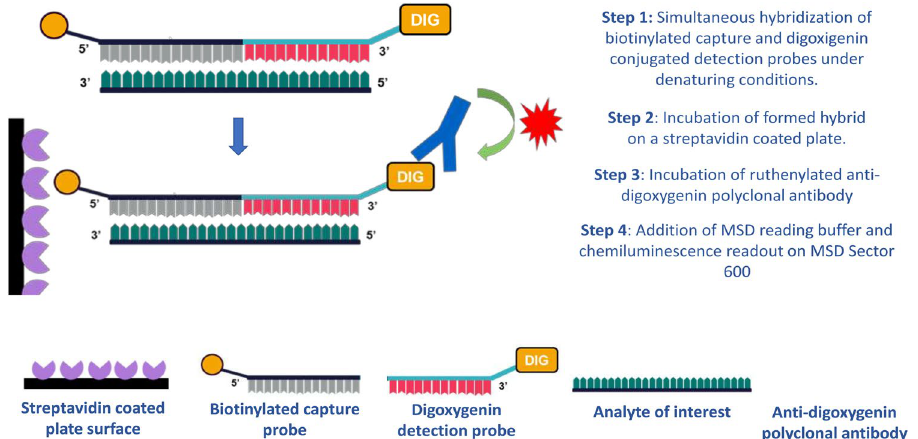
Figure 1. Illustration of the POE immunoassay sandwich with brief overview of assay